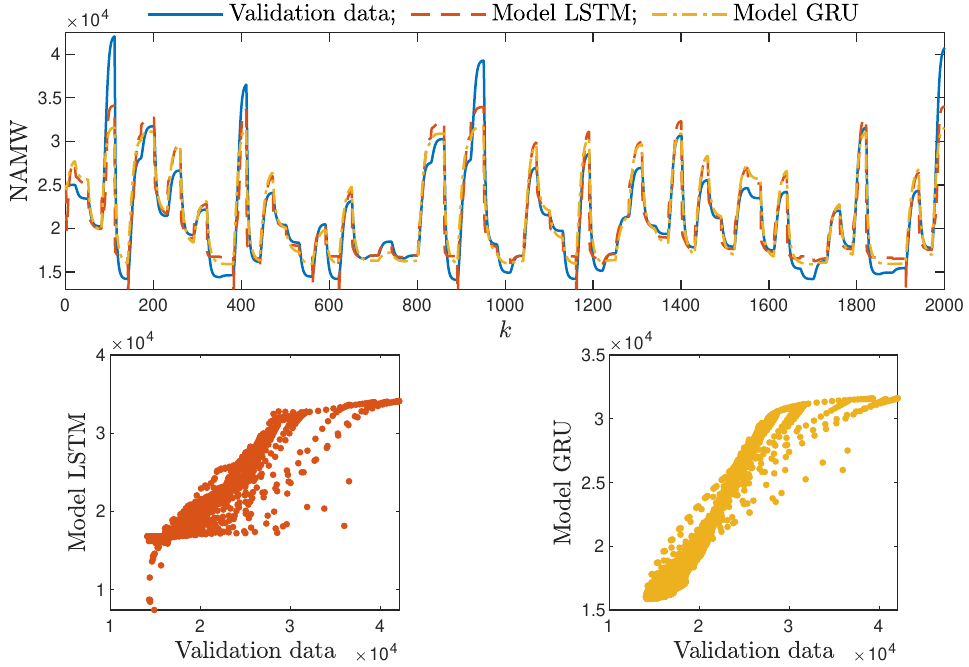
Figure 8. The polymerisation reactor: the validation dataset vs. the output of the LSTM and GRU models for n N = 1, n A = n B =